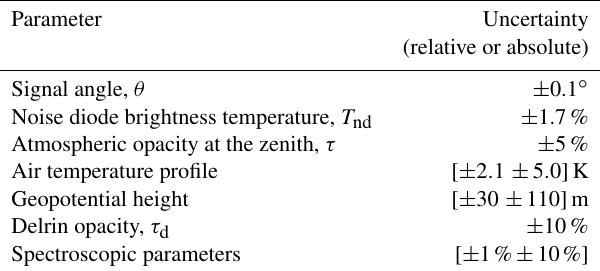
Table 4. Uncertainties on the various parameters used in the cali- bration process. When the uncertainty is a function of altitude the minimum and maximum values of the uncertainty are